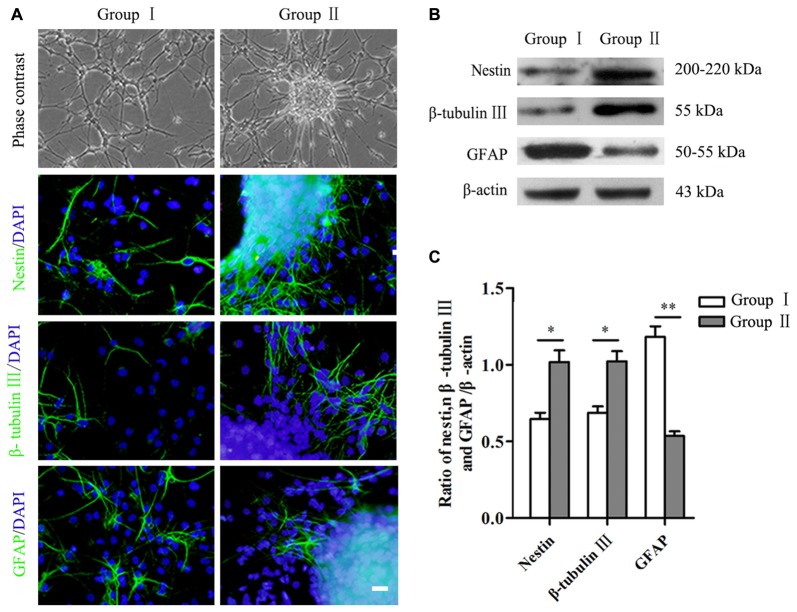
Differentiation of NSCs/NPCs. (A) Morphology and differentiation of NSCs/NPCs in both groups in differentiation medium (7 DIV), showed by immunostaining. (B,C) Significantly higher level of nestin, β-tubulin III and lower level of GFAP in Group II, showed by Western blot assay. Scale bar = 20 μm. The data were obtained from three independent experiments and three replicates for each experiment. The values are mean ± SD and analyzed via Student’s T test. Group II vs. Group I *P < 0.05, **P < 0.01.